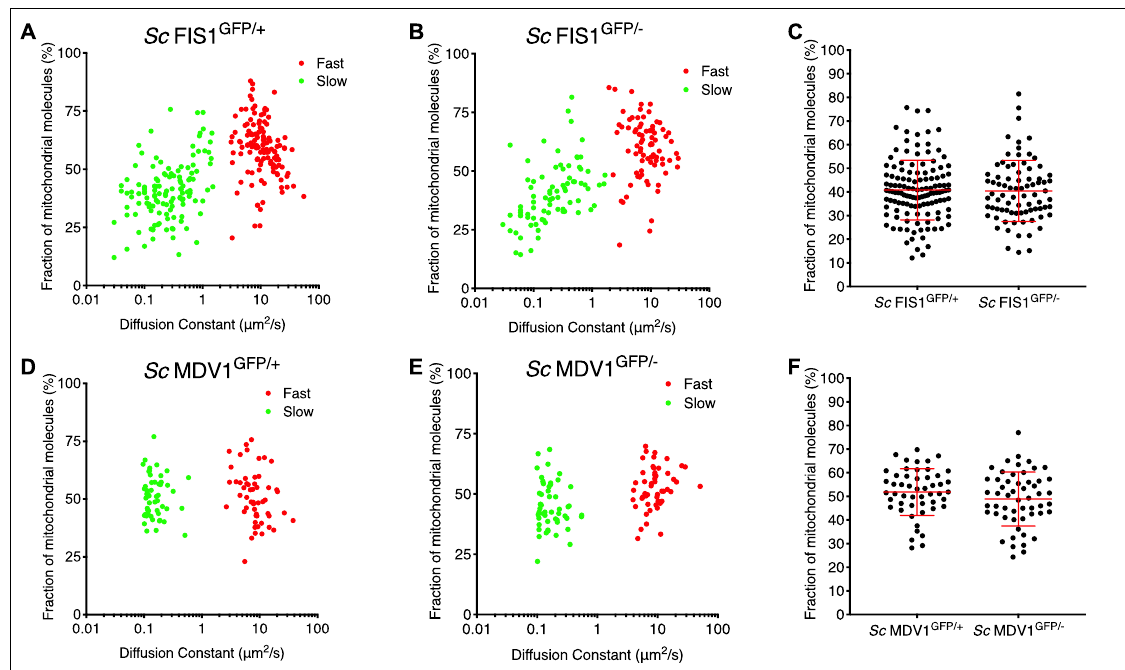
Figure 5. Modelling the mobility kinetics of Fis1p-GFP and Mdv1p-GFP molecules in yeast growing in rich fermentable medium. Mitochondrial Fis1p-GFP was measured in single Sc FIS1 GFP/+ ( n = 127) and Sc FIS1 GFP/− ( n = 80) cells growing in media containing glucose. The data obtained on the kinetics of Fis1p-GFP were fitted to a two-component model to estimate the numbers of fast-diffusing (red spots) and slow-diffusing (green spots) molecules. Shown are 2D plots comparing the diffusion rate to the fraction of mobile molecules measured in the confocal volume for the Sc FIS1 GFP/+ ( A ) and Sc FIS1 GFP/− ( B ) cells. The calculated percentage of molecules diffusing slowly was compared between the Sc FIS1 GFP/+ and Sc FIS1 GFP/− cells using the Mann – Whitney two-tailed t -test ( C ). Mitochondrial Mdv1p-GFP was measured in single Sc MDV1 GFP/+ ( n = 54) and Sc MDV1 GFP/− ( n = 51) cells growing in media containing glucose. The data obtained on the kinetics of M1,2dv1p-GFP were fitted to a two-component model to estimate the numbers of fast-diffusing (red dots) and slow-diffusing (green dots) molecules. Shown are 2D plots comparing the diffusion rate to the fraction of mobile molecules measured in the confocal volume for the Sc MDV1 GFP/+ ( D ) and Sc MDV1 GFP/− ( E ) cells ( F ). The calculated percentage of molecules diffusing slowly was compared between the Sc MDV1 GFP/+ and Sc MDV1 GFP/ − cells using the Mann – Whitney two-tailed t -test. Errors bars show mean and SD.